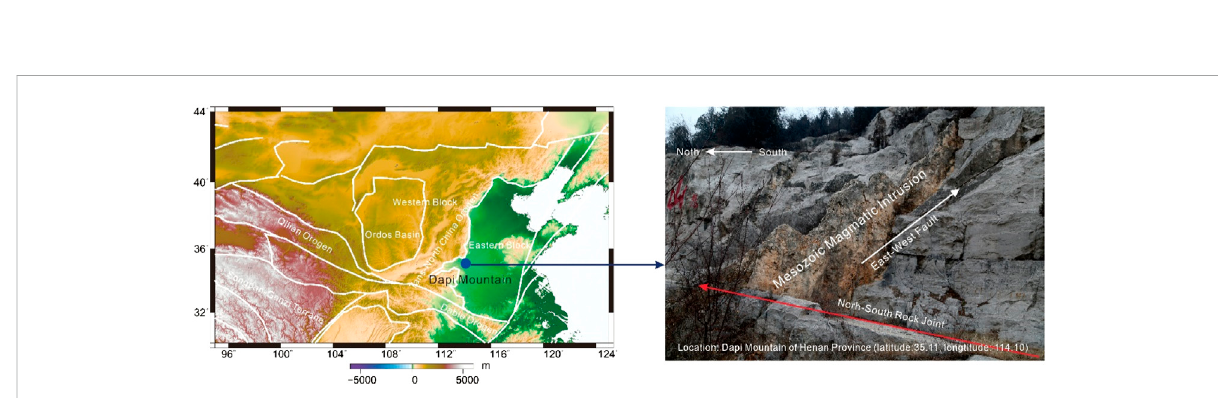
FIGURE 4 Example ofMesozoicmagmatic intrusion intheEasternBlock oftheNCC(thephotographintherightpanel was takenbyChuansongHeinthe Dapi Mountain of Henan